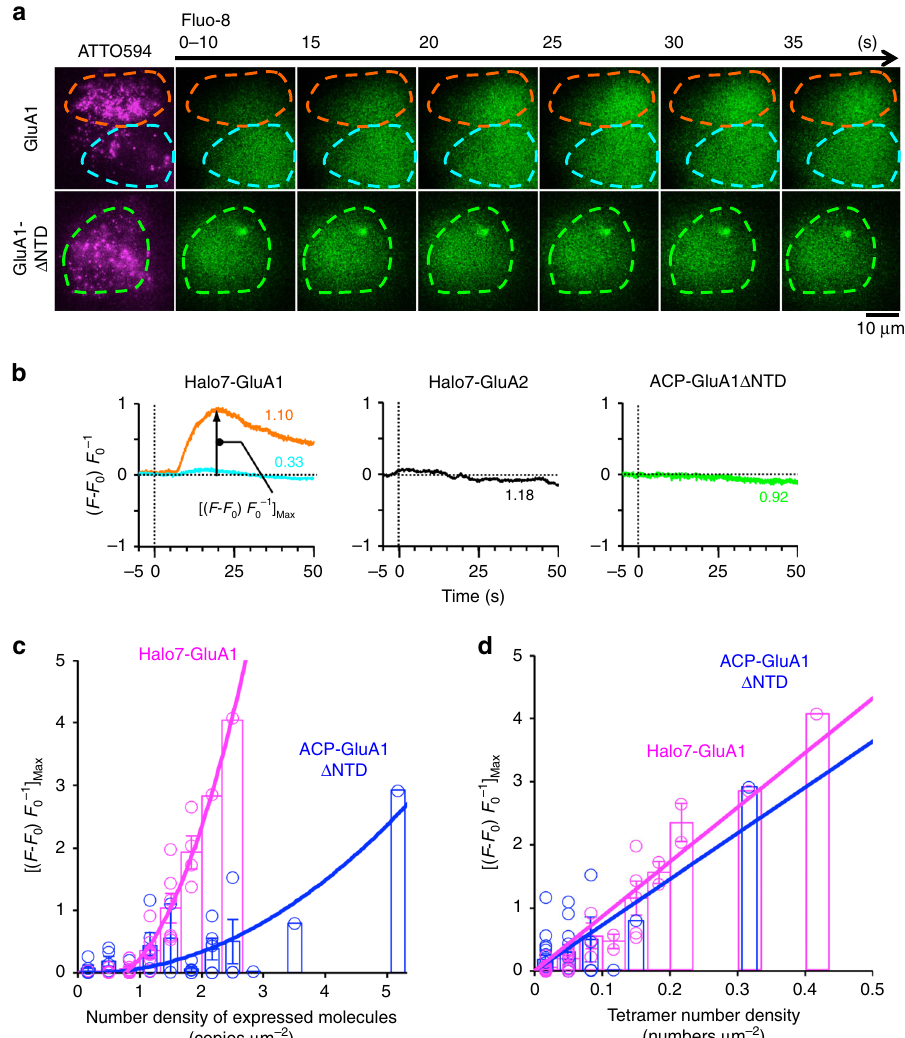
Fig. 6 Transient GluA1 homotetramers form Ca 2 + channels. a Typical time series of images of the Ca 2 + -sensitive dye Fluo-8 incorporated in the cytoplasm of HEK293 cells after L -glutamate stimulation (green images), with the images of ATTO594-labeled Halo7-GluA1 and ACP-GluA1 Δ NTD expressed in the same cells (magenta images). (Top row) Two cells expressing Halo7-GluA1 at high (1.10 copies μ m − 2 ) and low (0.33 copies μ m − 2 ) number densities exhibited large or virtually no Ca 2 + responses, respectively (typical results from 36 independent time series). (Bottom row) A cell expressing ACP- GluA1 Δ NTD at a high number density (0.92 copies μ m − 2 ), exhibiting no changes in the cytoplasmic Ca 2 + -concentration (among 38 independent time series). Since we were unable to express ACP-GluA1 at number densities of 1.10 copies μ m − 2 or higher, for these experiments, we employed Halo7-GluA1, which could be expressed up to 2.44 copies μ m − 2 . Dashed lines indicate the cell peripheries. b Time courses of the %increases in the Fluo-8 fl uorescence intensity ([ F - F 0 ] F 0 − 1 , where F and F 0 represent the fl uorescence intensities in the cytoplasm after background subtraction, measured at times t and 0, respectively) after stimulation (time 0, vertical dotted line). The values in the graph represent the number densities of molecules expressed in the PM (copies μ m − 2 ). (left) The time courses for the cells on the top (orange) and bottom (cyan) shown in a . (middle) The time course for cells expressing Halo7-GluA2 at a number density of 1.18 copies μ m − 2 (among 3 independent time series). (right) The time course of the cells expressing ACP- GluA1 Δ NTD, shown in the bottom row in a . c [( F - F 0 ) F 0 − 1 ] Max (see the graph in b ; mean ± SEM) plotted as a function of the number density of Halo7- GluA1 and ACP-GluA1 Δ NTD expressed in the PM (graph with a bin size; 0.333 copies μ m − 2 ). Curves are to help the eye ( fi tting with quadratic functions). For the numbers of observed cells, see the circles (Supplementary Table 8). d [( F - F 0 ) F 0 − 1 ] Max plotted as a function of the number density of homotetramers in the PM for Halo7-GluA1 and ACP-GluA1 Δ NTD. Each graph could be fi tted with a linear